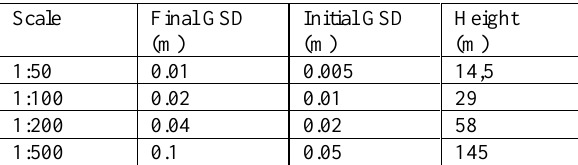
Table 2. Relationships between survey representation, GSD and flight height